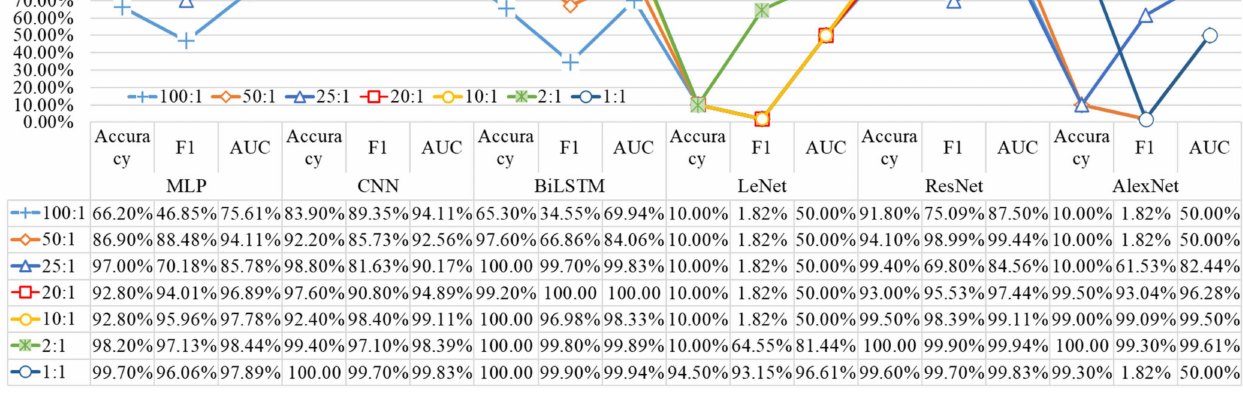
Figure 10. Diagnosis results with different classification models after using ACGAN-SN.